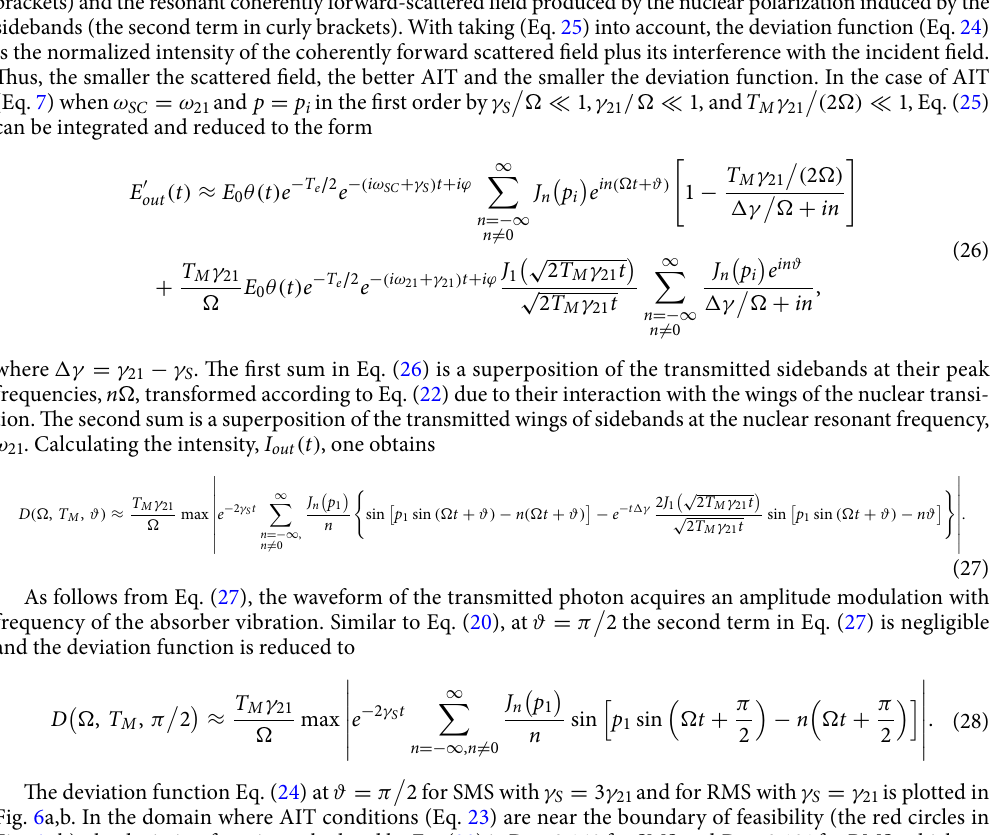
Fig. 6a,b. In the domain where AIT conditions (Eq. 23) are near the boundary of feasibility (the red circles in